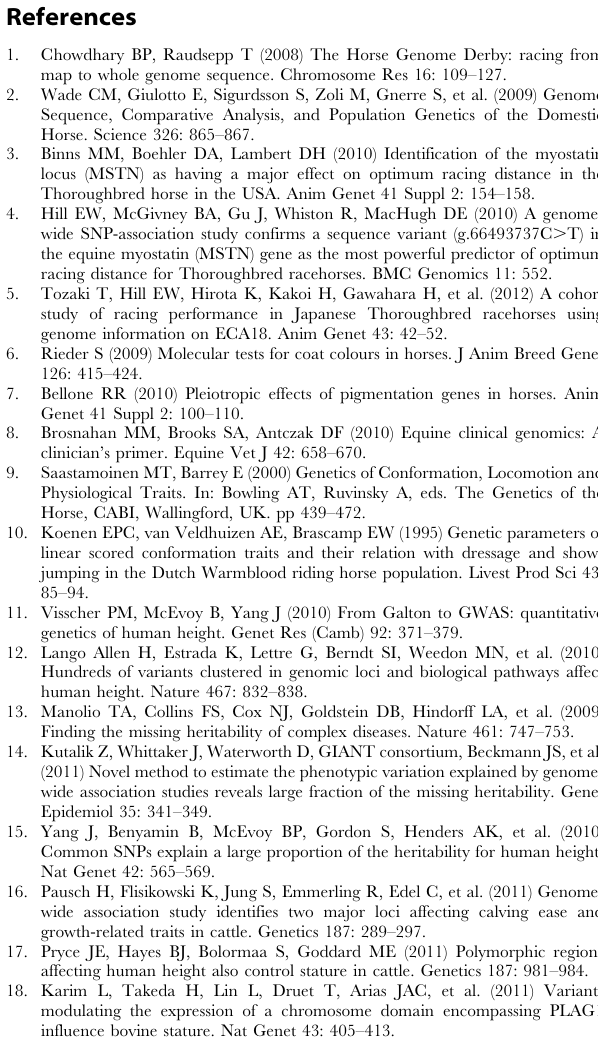
Figure S1 Distribution of genotyped FM horses ranked by the EBV for conformation type and the accuracy for this particular EBV. In practice the EBVs in the FM breed are scaled to a mean of 100 and a standard deviation of 20. The average EBV for animals born between 1998 and 2000 was set to